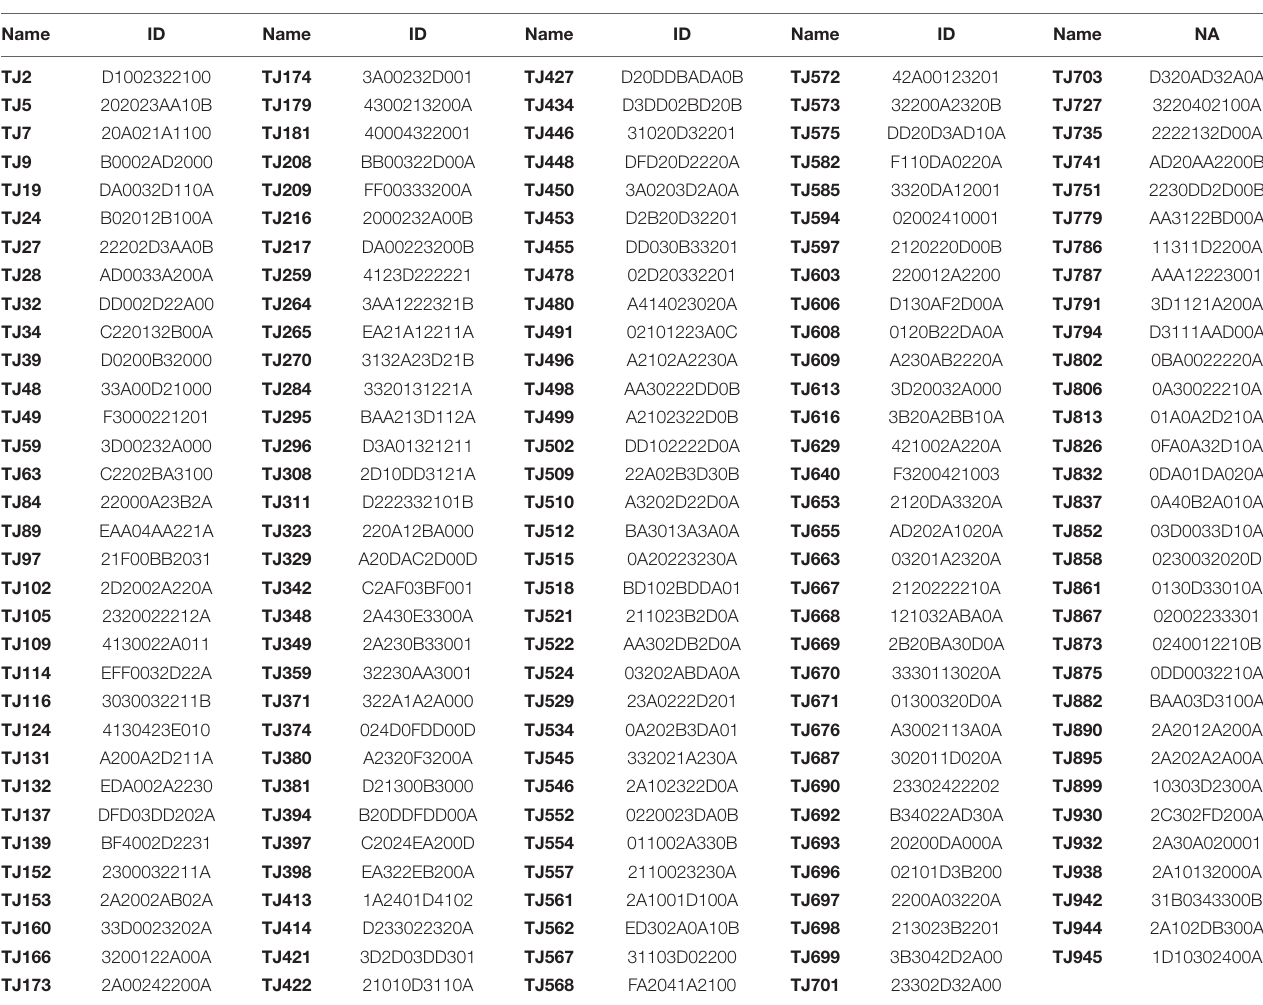
TABLE 2 | Members and molecular identity card of core